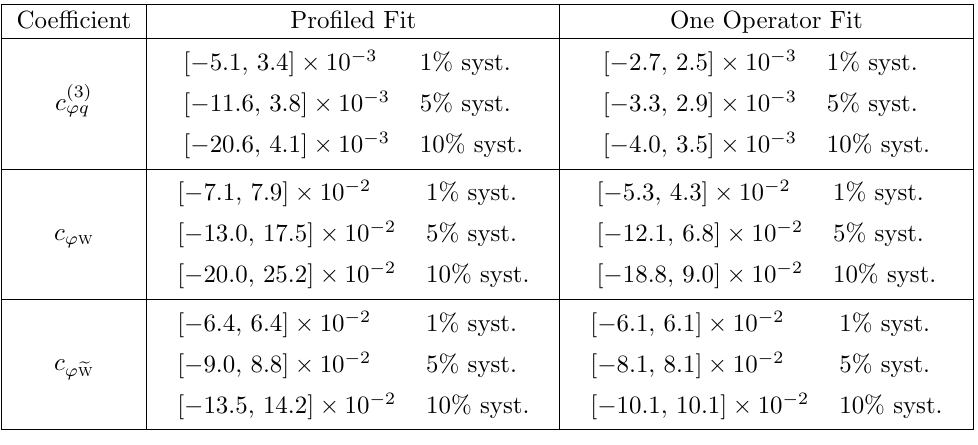
operators setting ’ e w